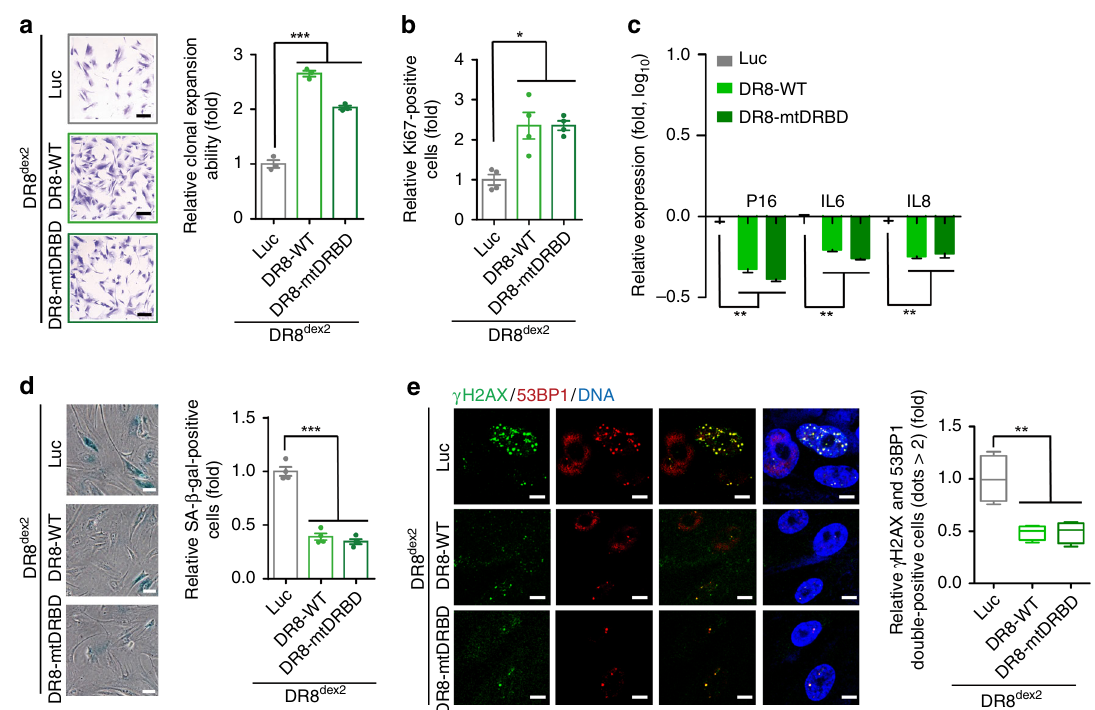
Fig. 3 DGCR8 regulates hMSC senescence in a miRNA processing-independent way. a Clonal expansion analysis of DR8 dex2 hMSCs transduced with lentiviruses expressing Luc, DR8-WT, or DR8-mtDRBD. Scale bar, 20 μ m. Data were presented as mean ± SEM. n = 3 wells per condition, *** p < 0.001. b Ki67 staining of DR8 dex2 hMSCs transduced with lentiviruses expressing Luc, DR8-WT, or DR8-mtDRBD. Data were presented as mean ± SEM. n = 4 images per condition, * p < 0.05. c RT-qPCR detection of P16, IL6, and IL8 in DR8 dex2 hMSCs transduced with lentiviruses expressing Luc, DR8-WT, or DR8- mtDRBD. Data were presented as mean ± SEM. n = 3 wells per condition, ** p < 0.01. d SA- β -gal staining of DR8 dex2 hMSCs transduced with lentiviruses expressing Luc, DR8-WT, or DR8-mtDRBD. Data were presented as mean ± SEM. n = 4 images per condition, *** p < 0.001. Scale bar, 20 μ m. e Immunostaining of γ H2AX and 53BP1 in DR8 dex2 hMSCs transduced with lentiviruses expressing Luc, DR8-WT, or DR8-mtDRBD. Data were presented as mean ± SEM. n = 4 images per condition, ** p < 0.01. Scale bar, 10 μ m. Box plots show the median (center line inside the box), upper and lower quartiles (bounds of box), largest and smallest values